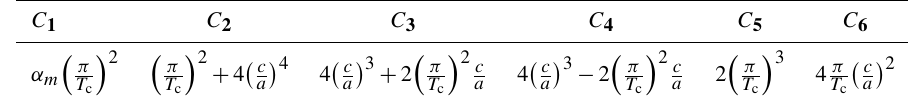
Table B1. Coefficients C 1 ... 6 used in the analytical model of impact of Akay and Hodgson (1978). C 1 C 2 C 3 C 4 C 5 C 6 (cid:16) π (cid:17) α m T c